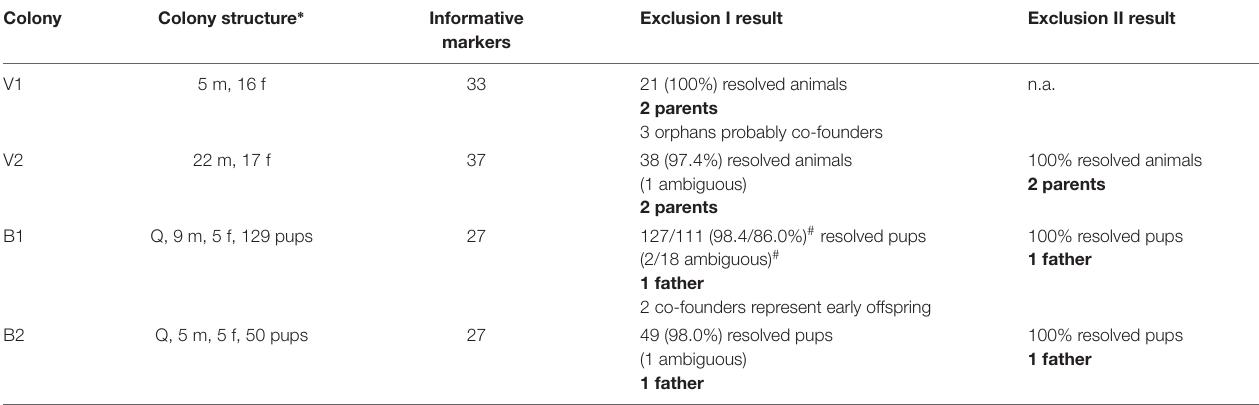
TABLE 1 | Parental analysis of NMR colonies using Mendelian exclusion approaches.